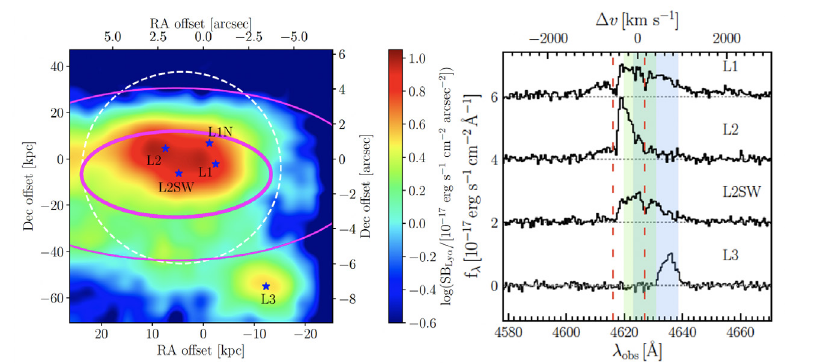
Figure 3: Left: Continuum-subtracted Ly ↵ emission of the gas surrounding SMM J02399 0136. The two magenta ellipses show the size of the turbulent reservoir traced − by CH + (1-0) absorption, derived for two durations of the starburst phase, 50Myr (thick) and 100Myr (thick). Right: Ly ↵ spectra observed in the direction of L1, L2, L2SW and L3. The blue and green shaded regions mark the velocities of the CH + (1-0) absorption lines towards L2SW and